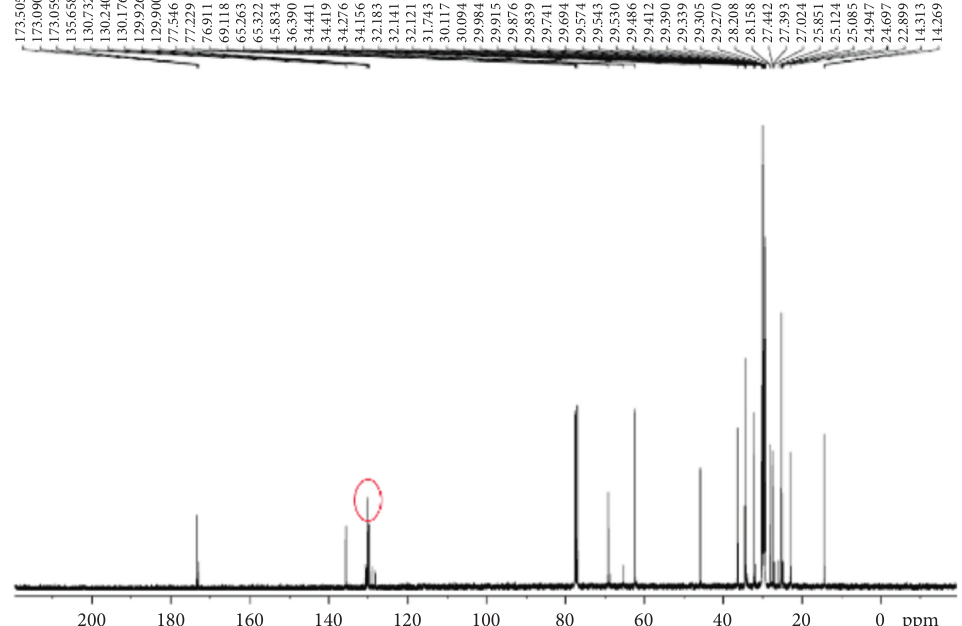
Figure 21: 13 C NMR spectra of chaulmoogra oil showing chemical shift corresponding to carbon connected to the vinylic proton in cyclopentene.